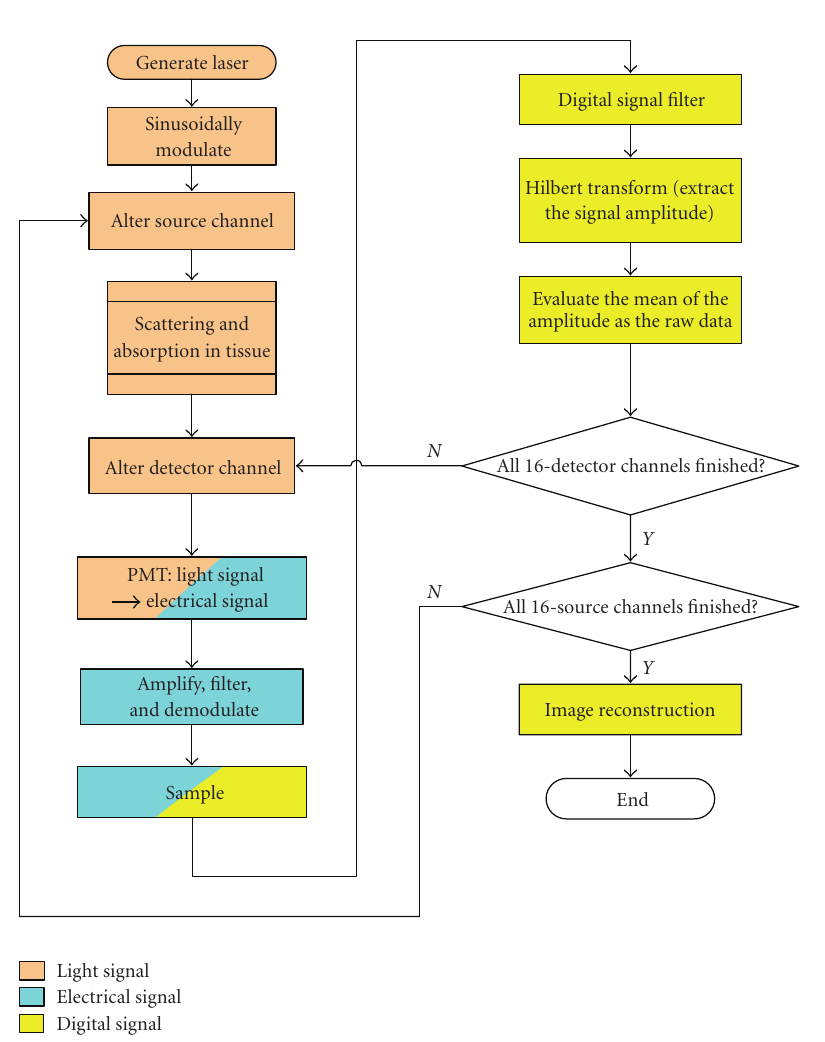
Figure 5: Flow chart of data acquisition and control